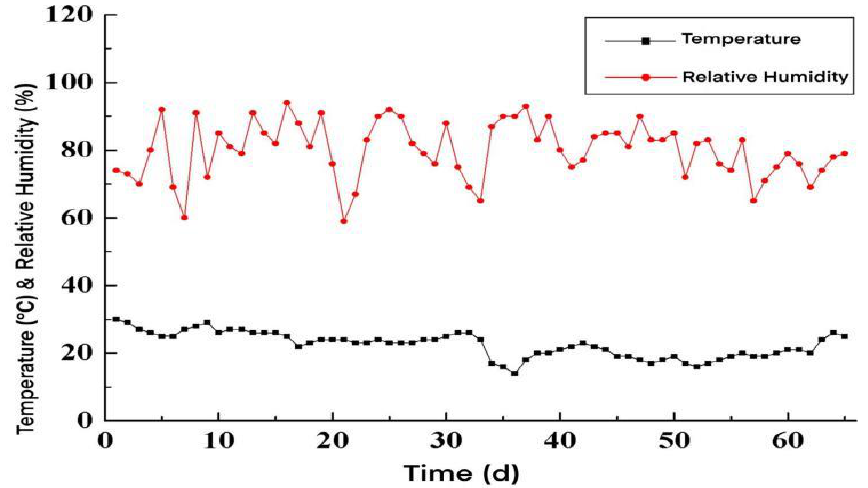
Figure 4. The change in temperature and relative humidity in the natural curing environment.